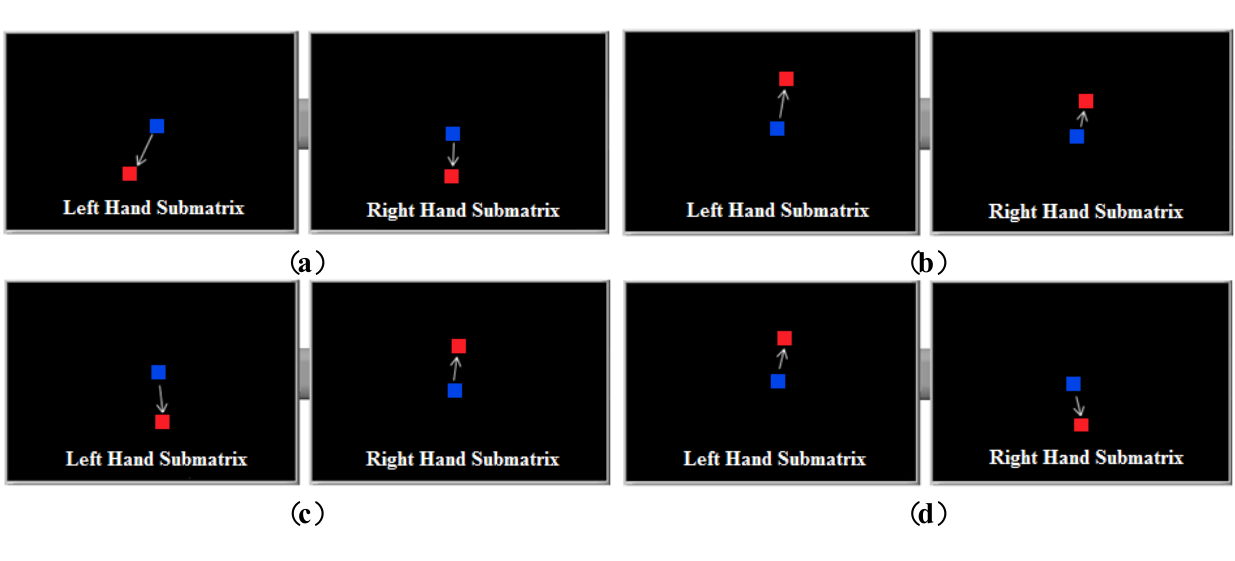
Figure 10. Displacement of the center of mass under different maneuvers registered with the prototype in Figure 3: ( a ) forward movement; ( b ) backward movement; ( c ) turn to the right; and ( d ) turn to the